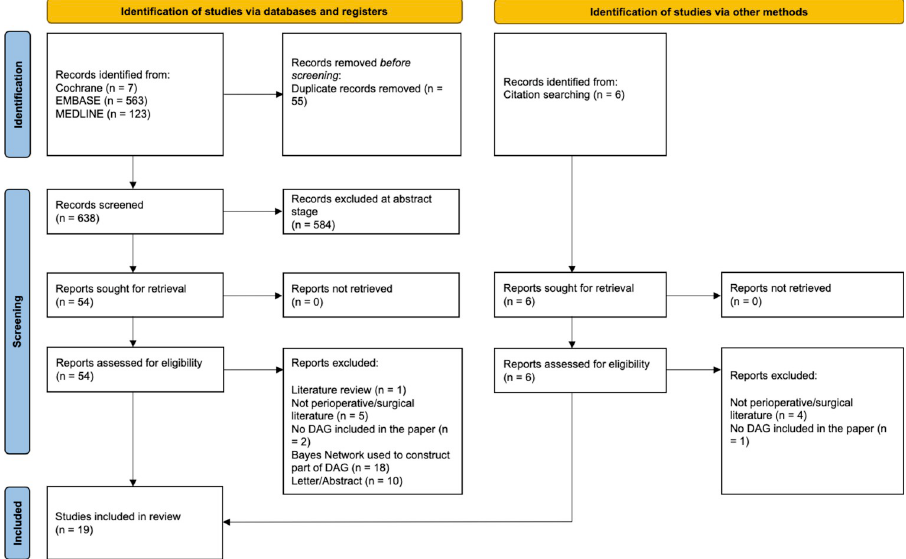
Fig 1. PRISMA flowchart of studies included in the final synthesis of the systematic